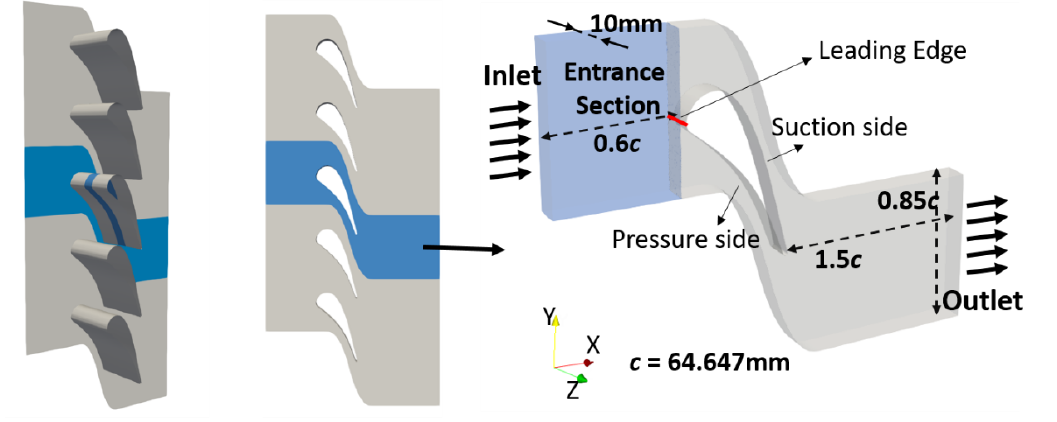
Figure 1. Sketch of the numerical configuration